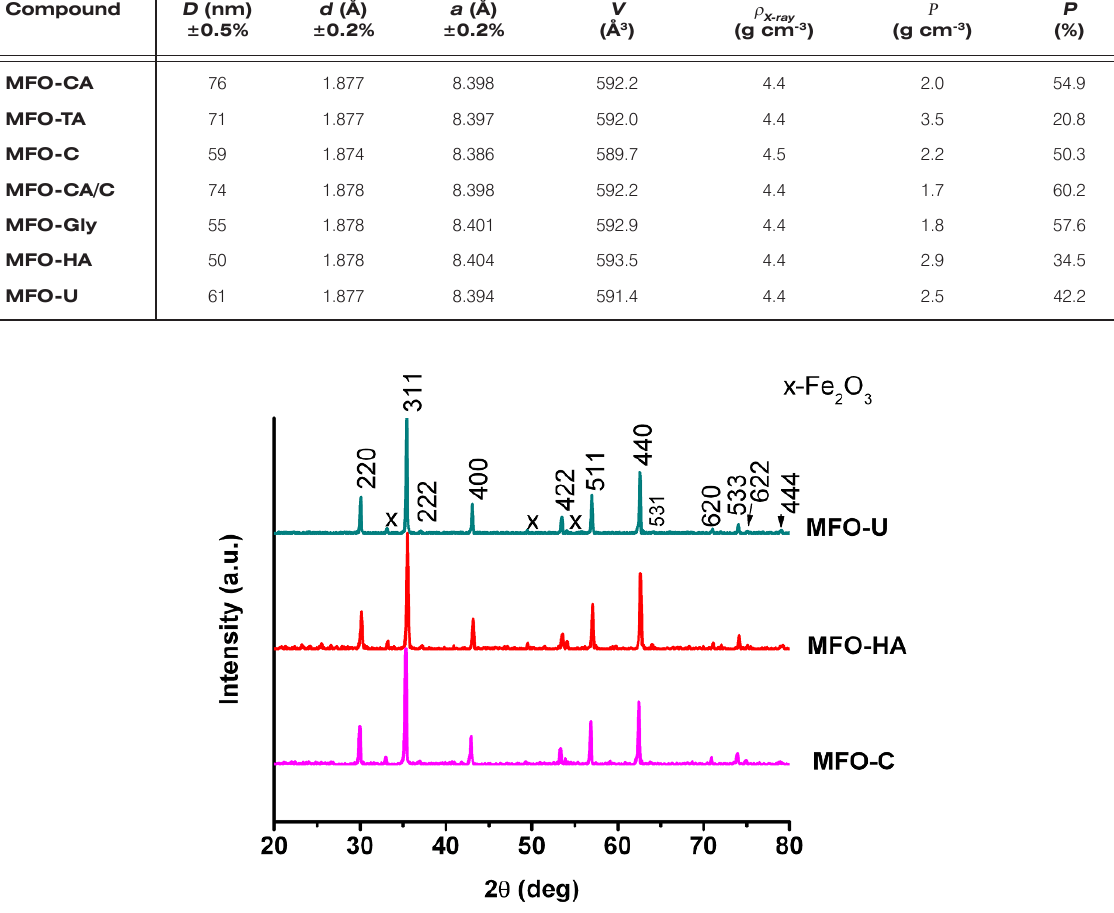
Figure 7. X-ray diffraction patterns of MgFe